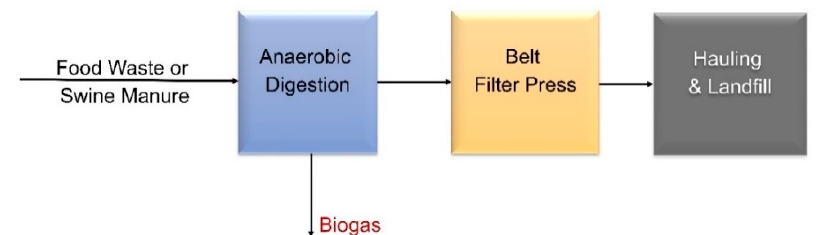
Figure 5. Process Flow Diagram of an AD Facility Converting Food Waste or Manure as Modeled in CapdetWorks.